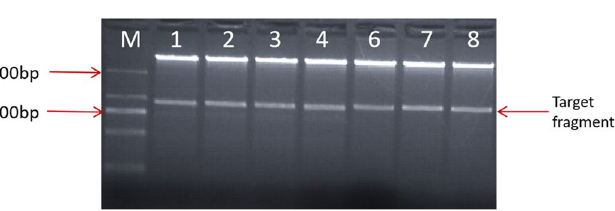
Figure 3. Double restriction digestion of the target gene and vector. M: 2000 bp DNA molecular marker; 1–8: transgenic